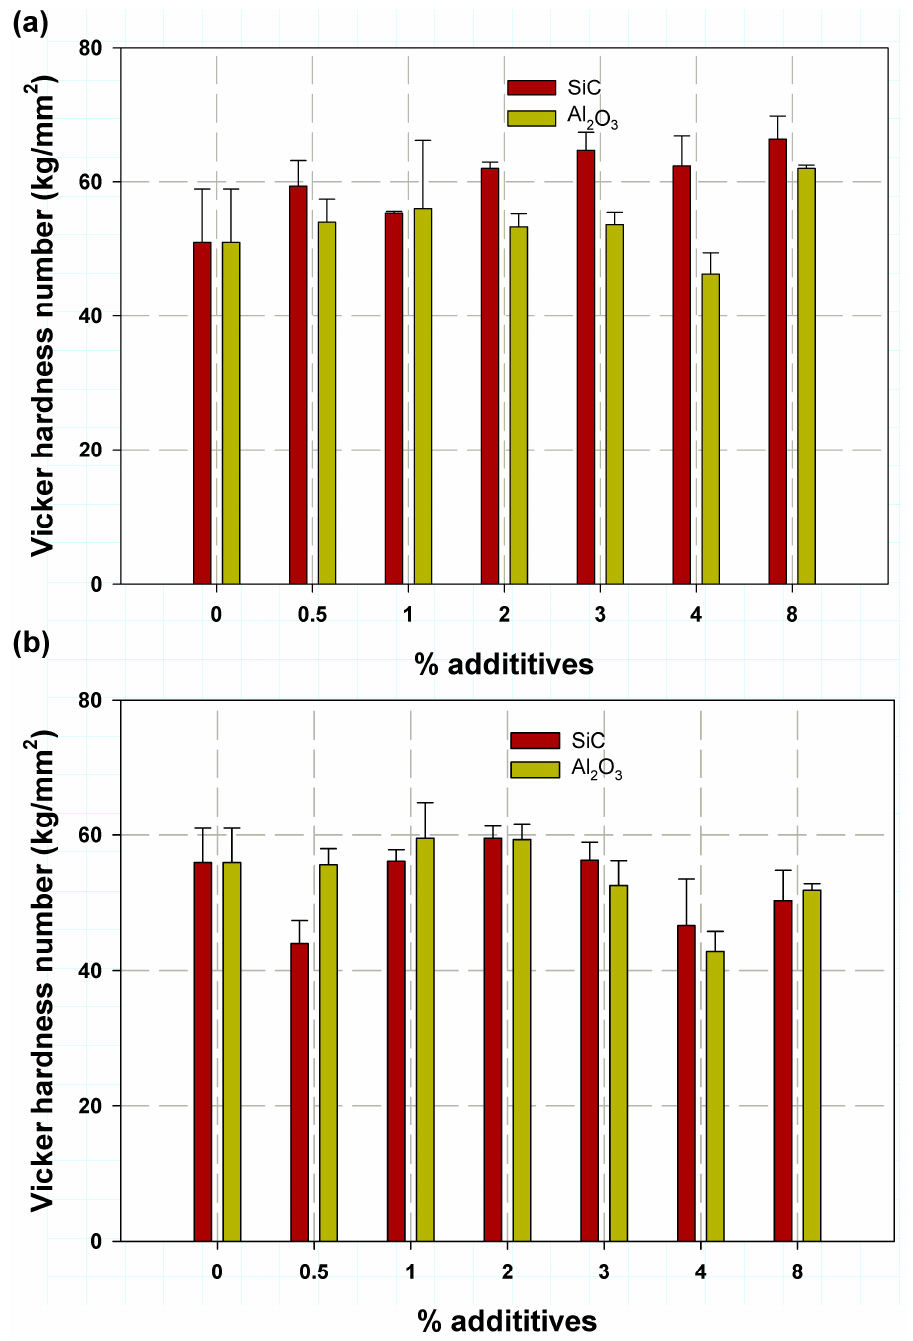
Figure 9. Vicker’s hardness variation with different ceramic additives: ( a ) graphite mold, ( b ) steel